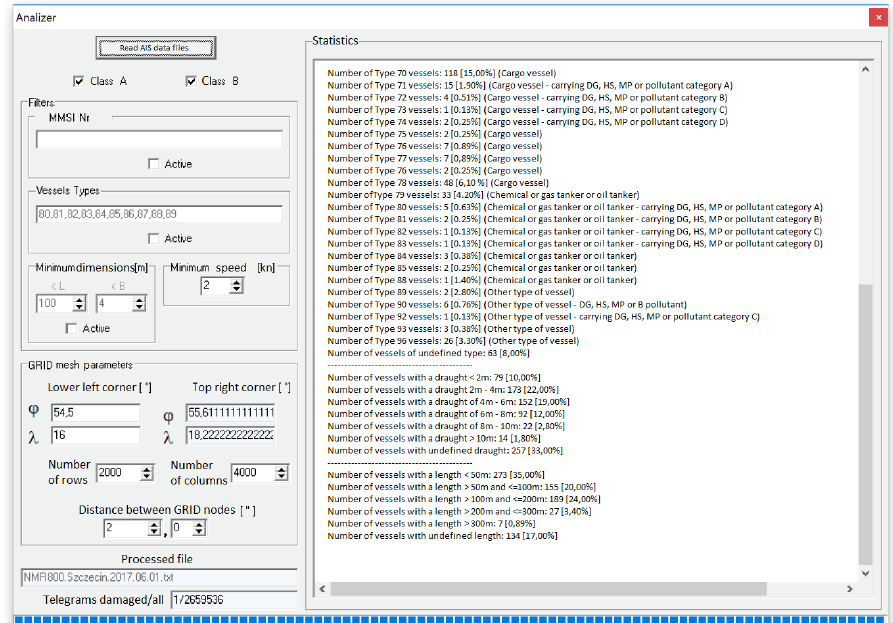
Figure 2. The main window of the “Analyzer” software application.